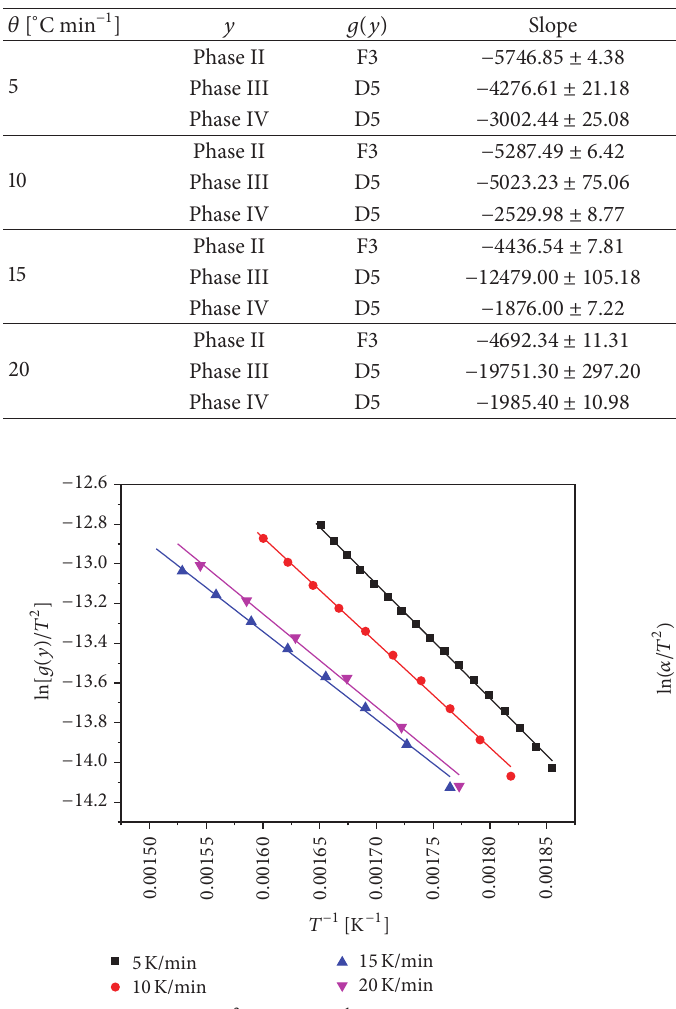
Figure 6: The ln [𝑔(𝑦)/𝑇 2 ] versus 𝑇 −1 of different heating rate in phase II.